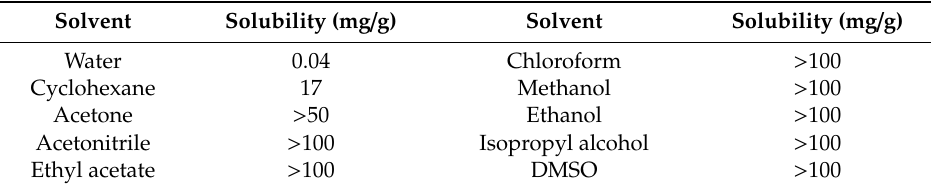
Table 1. Solubility of CsA in selected